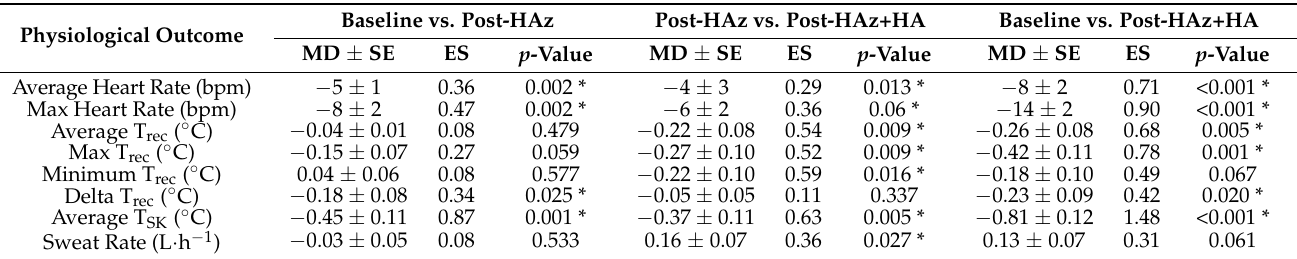
Baseline: Unacclimated; post-HAz: post-heat acclimatization; post-HAz+HA: post-heat acclimatization + heat acclimation; negative values indicate the later test is lower than the earlier test; positive values indicate later test is higher than earlier test; data are presented as mean difference ± standard error and effect size; * indicates statistical significance, p <